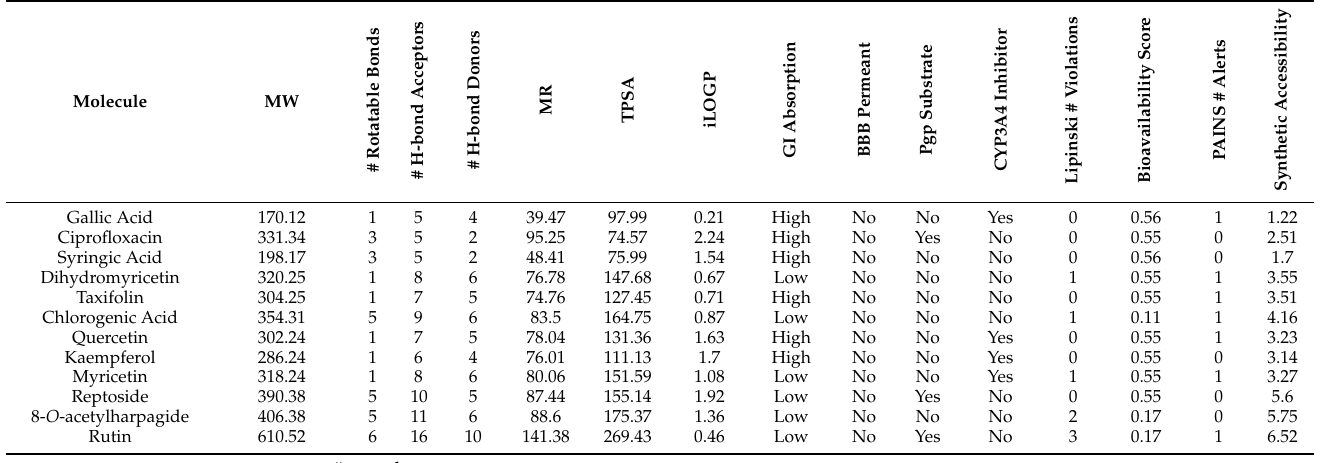
Table 5. Physicochemical and pharmacokinetic properties of ligands retrieved from SwissADME (Supplementary Material S2).